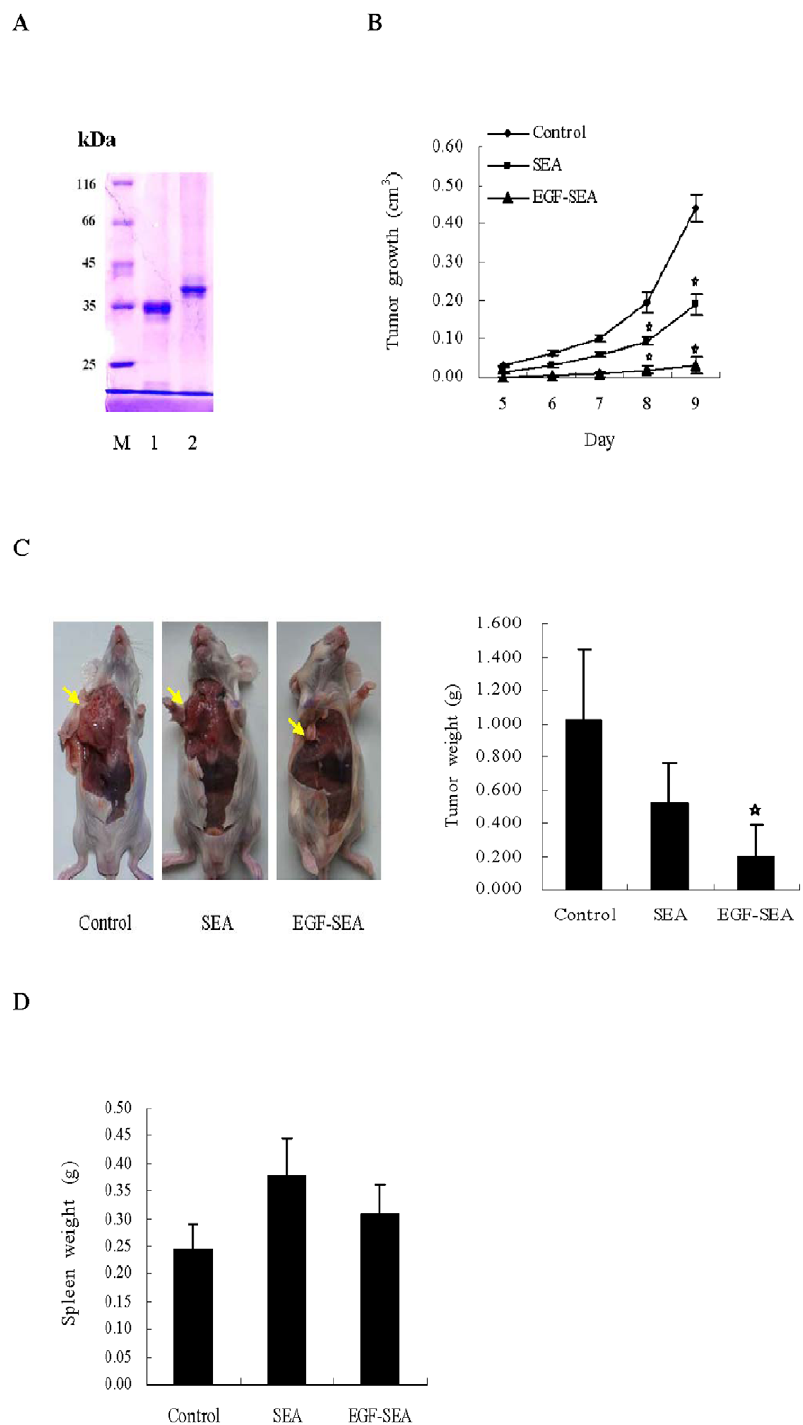
Figure 1. Inhibition of S180 tumor growth. (A) SDS-PAGE identification of proteins. Lane 1, SEA; lane 2, EGF-SEA. (B) Effect of treatments on the growth of S180 tumors. After mice were inoculated with 2 6 10 6 S180 cells into the right axilla, they were treated with two daily i.p. injections (0.2 ml) of 0.9% NaCl saline (control), SEA (250 pmol) and EGF-SEA (250 pmol) starting 1 day after tumor inoculation. n=15 mice per group. *p , 0.001. (C) Inhibition of S180 tumors. Mice were dissected and the tumors were measured on day 9. Yellow arrows indicated the tumor position. *p , 0.001. (D) Effect of treatments on spleens. doi:10.1371/journal.pone.0016642.g001 To examine antitumor cytotoxicity induced by EGF-SEA, S180 SEA, respectively. The solid tumors appeared on day 5 and cells were subcutaneously inoculated into the right axilla of ICR quickly expanded over the next 2 days in the control mice, while mice, followed by i.p. injections of saline (control), SEA, or EGF- the growth of tumors was delayed in mice treated with EGF-SEA